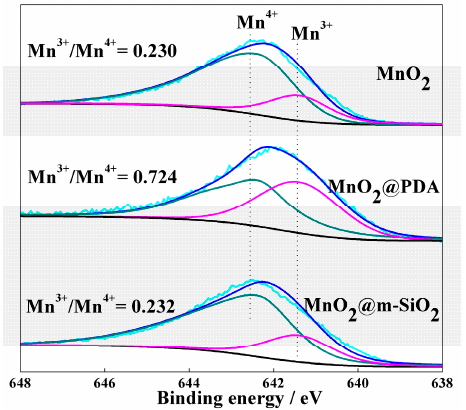
Figure 3. Non ‐ normalized and curve fitted Mn 2p3/2 XPS spectra of MnO 2 , MnO 2 @PDA, and MnO 2 @m ‐ SiO 2 .